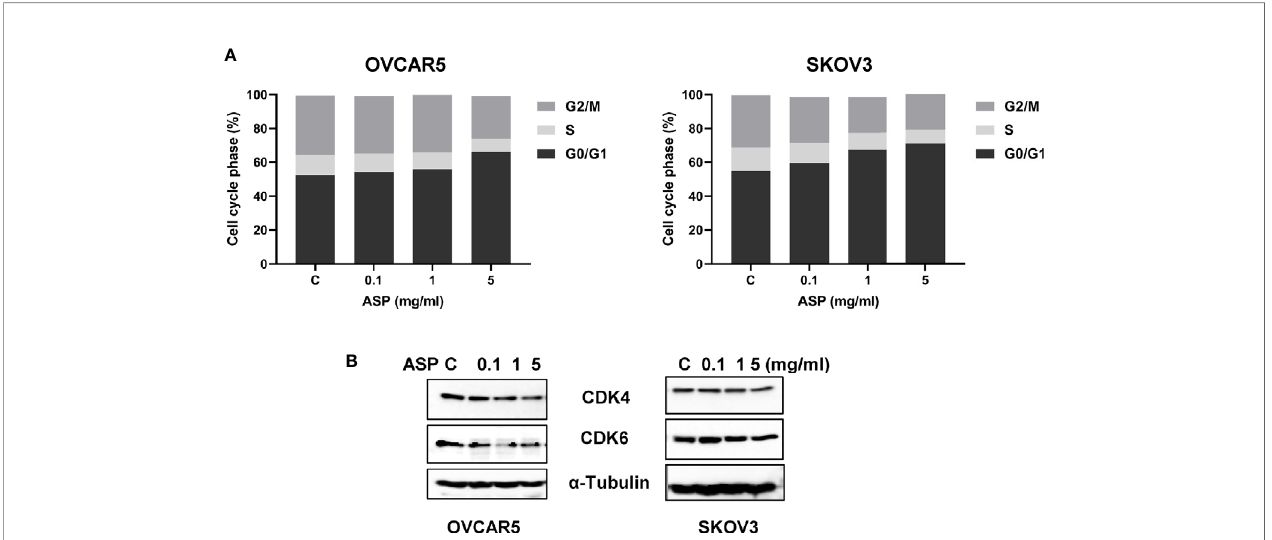
FIGURE 3 | Induction of cell cycle G1 arrest by ASP is dose-dependent. The OVCAR5 and SKOV3 cells were incubated in the presence of the indicated doses of ASP for 48 hours. The cell cycle phase distribution was determined by Cellometer. ASP induced an arrest of cells at the G1 phase in a dose-dependent manner in both OVCAR5 and SKOV3 cells (A) . To evaluate expression of cell cycle related proteins, the OVCAR5 and SKOV3 cells were treated with ASP for 24 hours. Western blotting results showed that the expression of CDK4 and CDK6 proteins were decreased after treatment with ASP (B) . The results shown are one of three independent